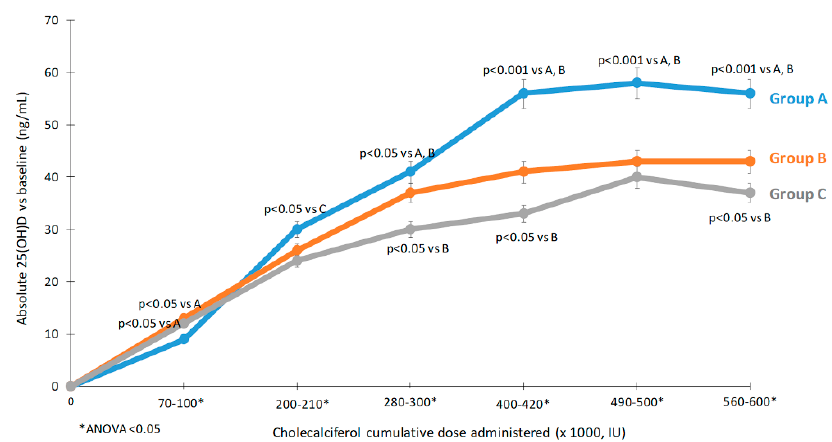
Figure 4. Relationship between the 25 (OH)D increase with respect to the cumulative dose reached among the three different groups. Group A 10,000 IU daily, Group B 50,000 IU weekly, Group C 100,000 IU biweekly. * ANOVA p < 0.05. Group A; 10,000 IU daily, Group B; 50,000 IU weekly and Group C; 100,000 IU bi-weekly doses of cholecalciferol. Data presented as mean ± SD.